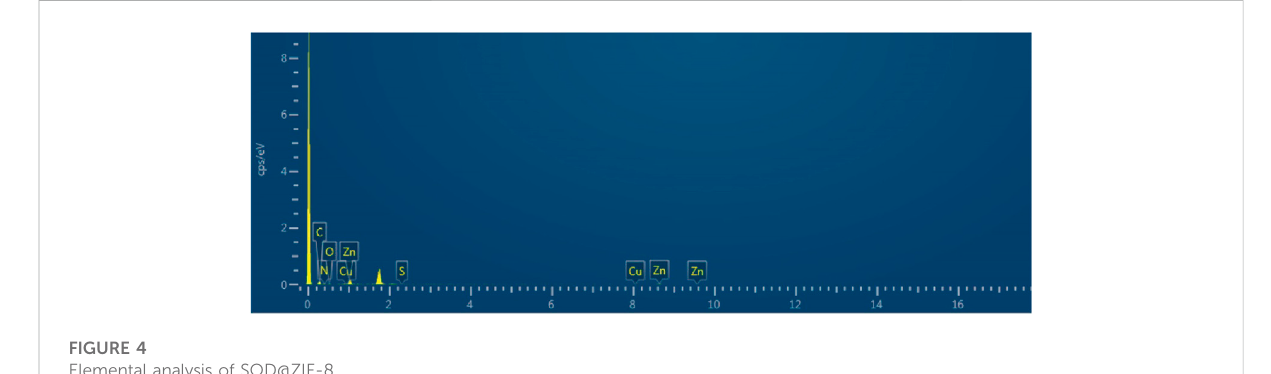
FIGURE 4 Elemental analysis of SOD@ZIF-8.